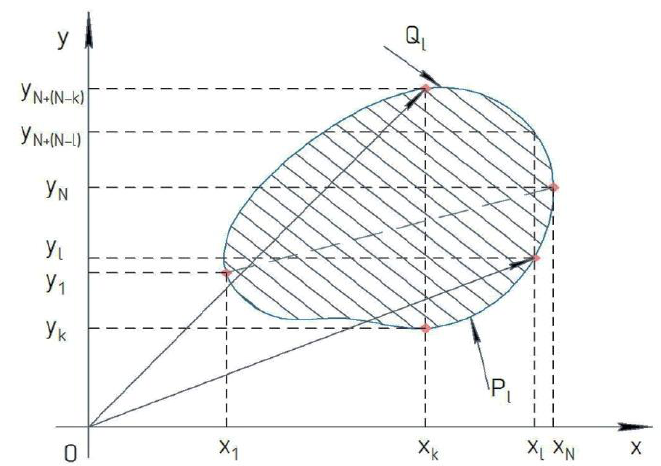
Figure 3. The closed curve with a partition in the form of a contour of two non-intersecting